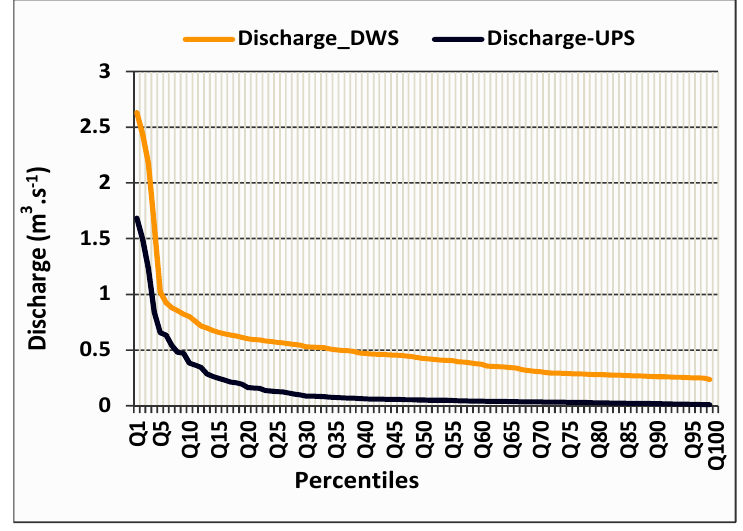
Figure 4. Monthly flow duration in Muooni catchment.